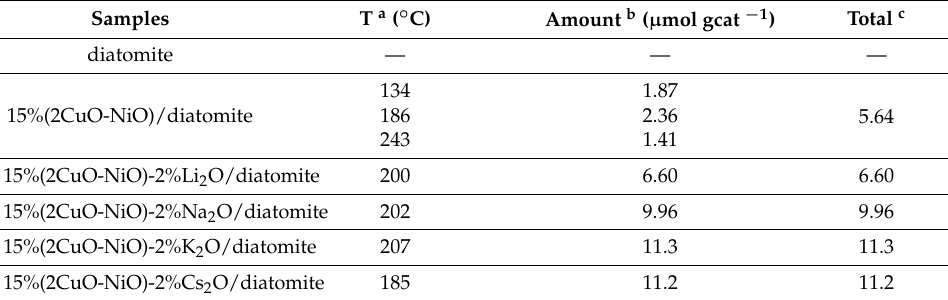
Table 2. Quantification of the NH 3 -TPD profiles of as-prepared catalysts.